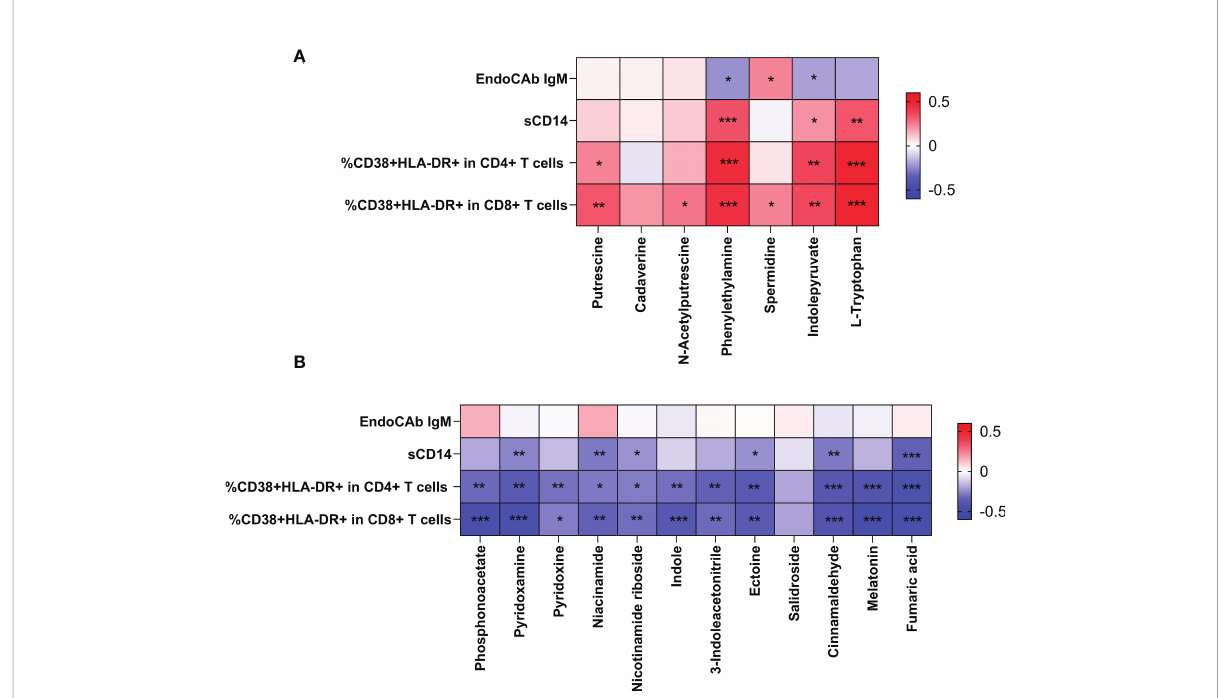
FIGURE 6 Correlation of the differential metabolites with immune activation and microbial translocation. The positive Spearman rank correlation coef fi cients are denoted by red squares, and negative correlation coef fi cients by blue squares. The metabolites, exhibited higher levels in HIV- positive individuals, were positively correlated with microbial translocation and immune activation (A) . In contrast, metabolites, exhibited lower levels in HIV-positive individuals, were negatively correlated with immune activation and microbial translocation (B) . *: 0.010 ≤ P < 0.050; **: 0.001 ≤ P < 0.010; ***: P <